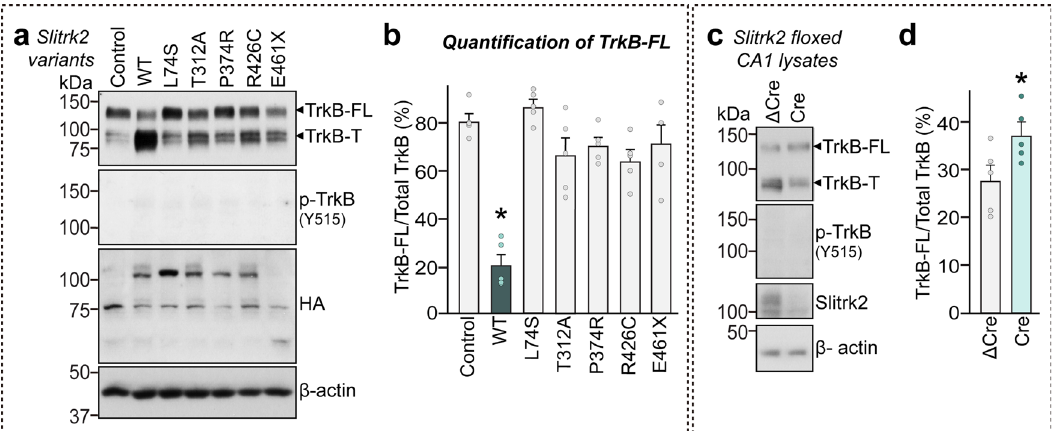
Fig. 7 Alterations of full-length TrkB protein levels in cultured neurons by a subset of SLITRK2 variants. Cultured cortical neurons were infected with lentiviruses expressing WT or the indicated mutant forms of SLITRK2. Levels of TrkB were examined by semi-quantitative immunoblotting using antibodies against TrkB or phospho-TrkB. FL full-length, T truncated. b Quanti fi cation of protein levels from ( a ). Summary data showing plots from fi ve independent experiments. Data are mean ± SEMs (* p < 0.05; ANOVA with a non-parametric Kruskal – Wallis test). c Hippocampal CA1 lysates from Slitrk2- fl oxed mice infected with AAVs expressing Δ Cre or Cre were examined by semi-quantitative immunoblotting using antibodies against TrkB or phospho-TrkB. FL full-length, T truncated. d Quanti fi cation of protein levels from ( c ). Data are means ± SEMs ( n = 5 mouse samples; * p < 0.05; two-tailed unpaired t -test). See Source data for raw data values and Supplementary Table 4 for statistical